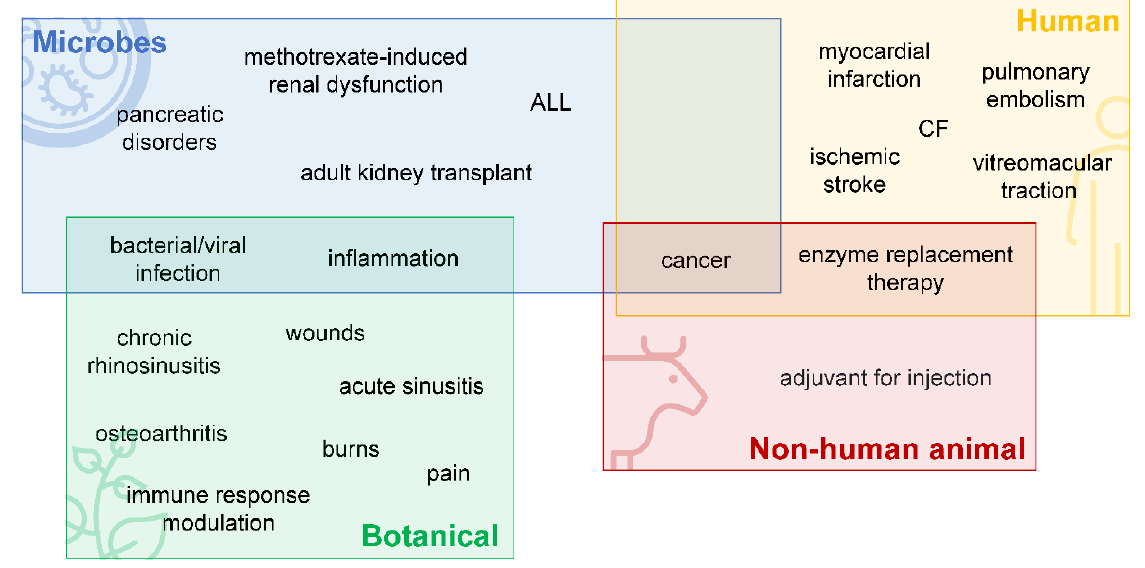
Figure 2. Graphic representations of the different origins for enzymes used in enzyme therapeutics with their current/potential uses listed. Microorganisms, plants, non-human animals, and humans are all sources for enzymes in therapeutics. Enzyme therapies are currently available to treat a wide variety of diseases, including cancers, infections, wounds, and as enzyme replacement therapy for metabolic diseases. NB, this figure represents the information described in this review and is not intended to provide an exhaustive list. ALL, acute lymphoblastic leukaemia; CF, cystic fibrosis.